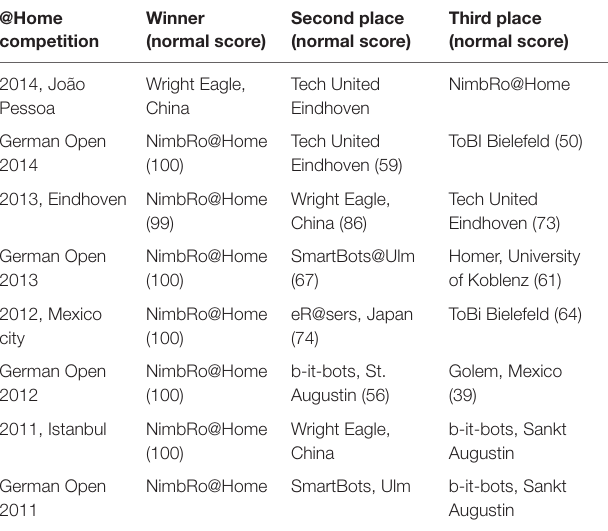
TABle 1 | Robocup@home competition results